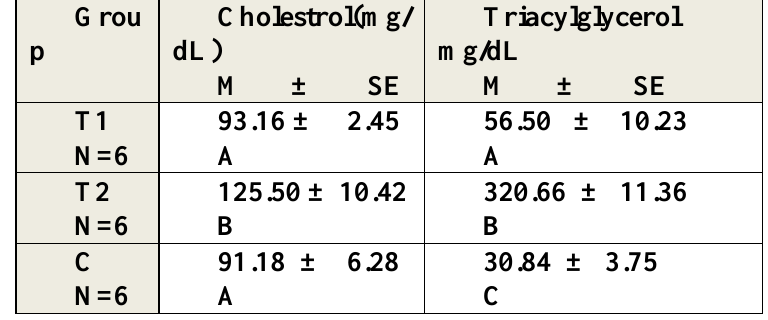
Table(4):-The serum cholesterol mg/dL and triacylglycerol mg/dL of rats dosed orally therapeutic dose 1mg/kg.BW of oseltamivir for different experimental periods.